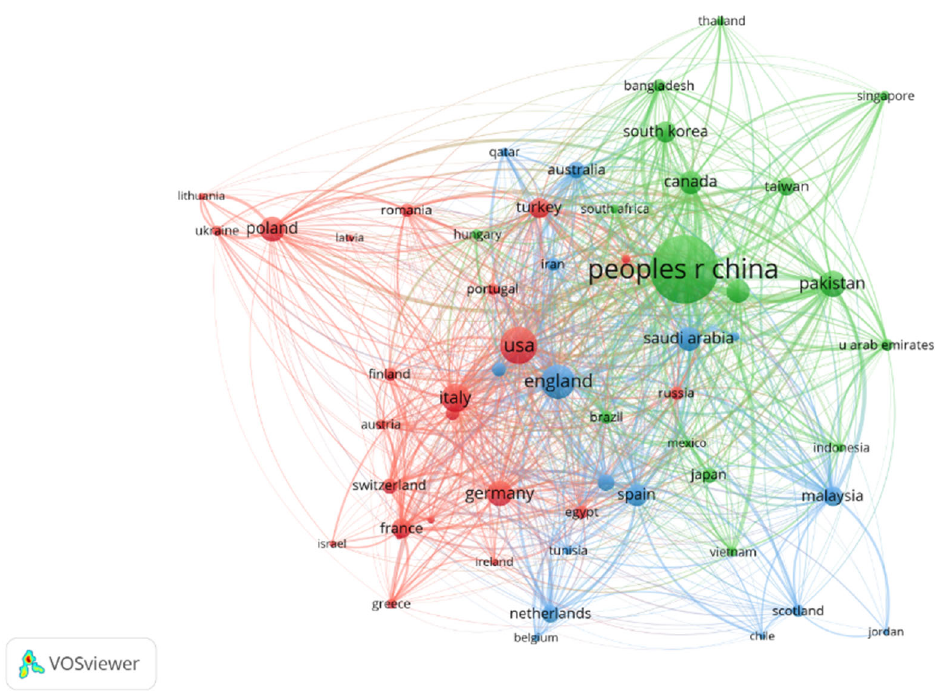
Figure 7. Bibliographic coupling of countries. Energies 2023 , 16 , x FOR PEER REVIEW